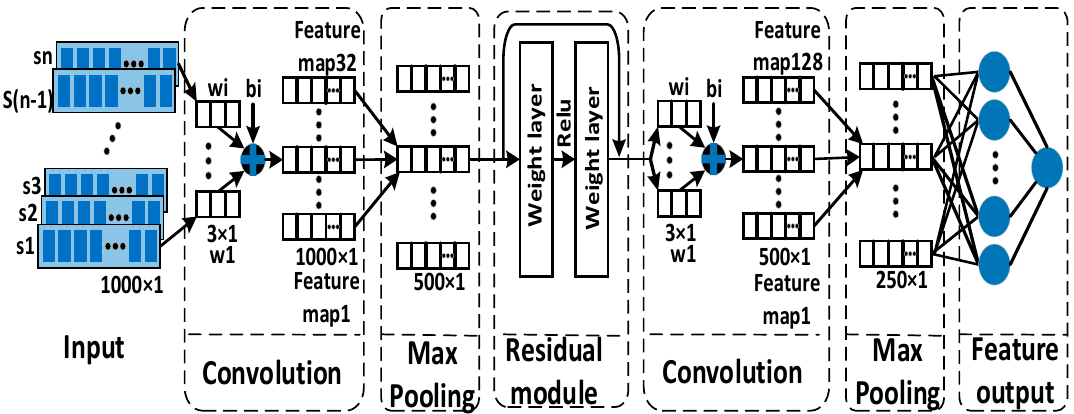
Figure 2. One-dimensional convolutional neural network model structure.